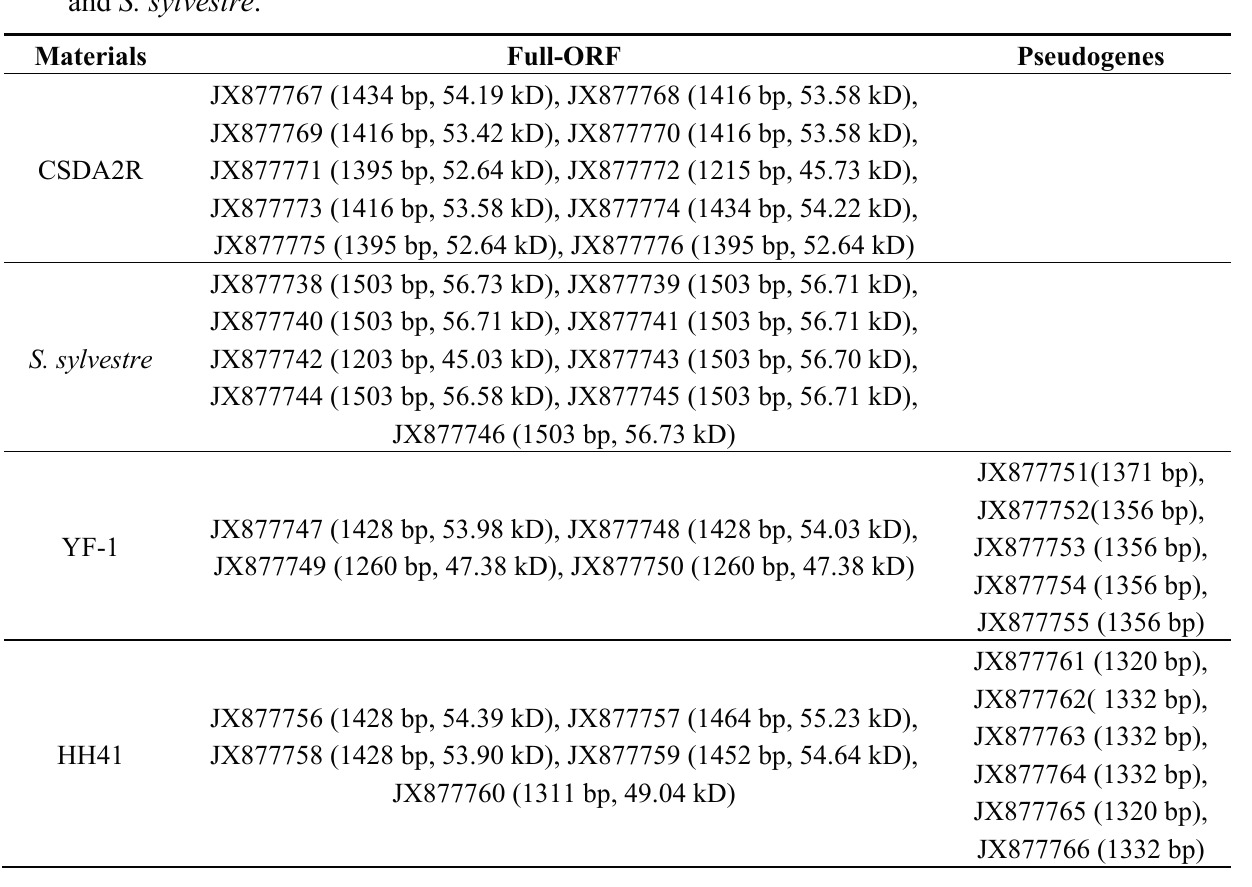
Table 1. The Sec2 sequences isolated from wheat— S. africanum derivatives, S. cereale and S. sylvestre